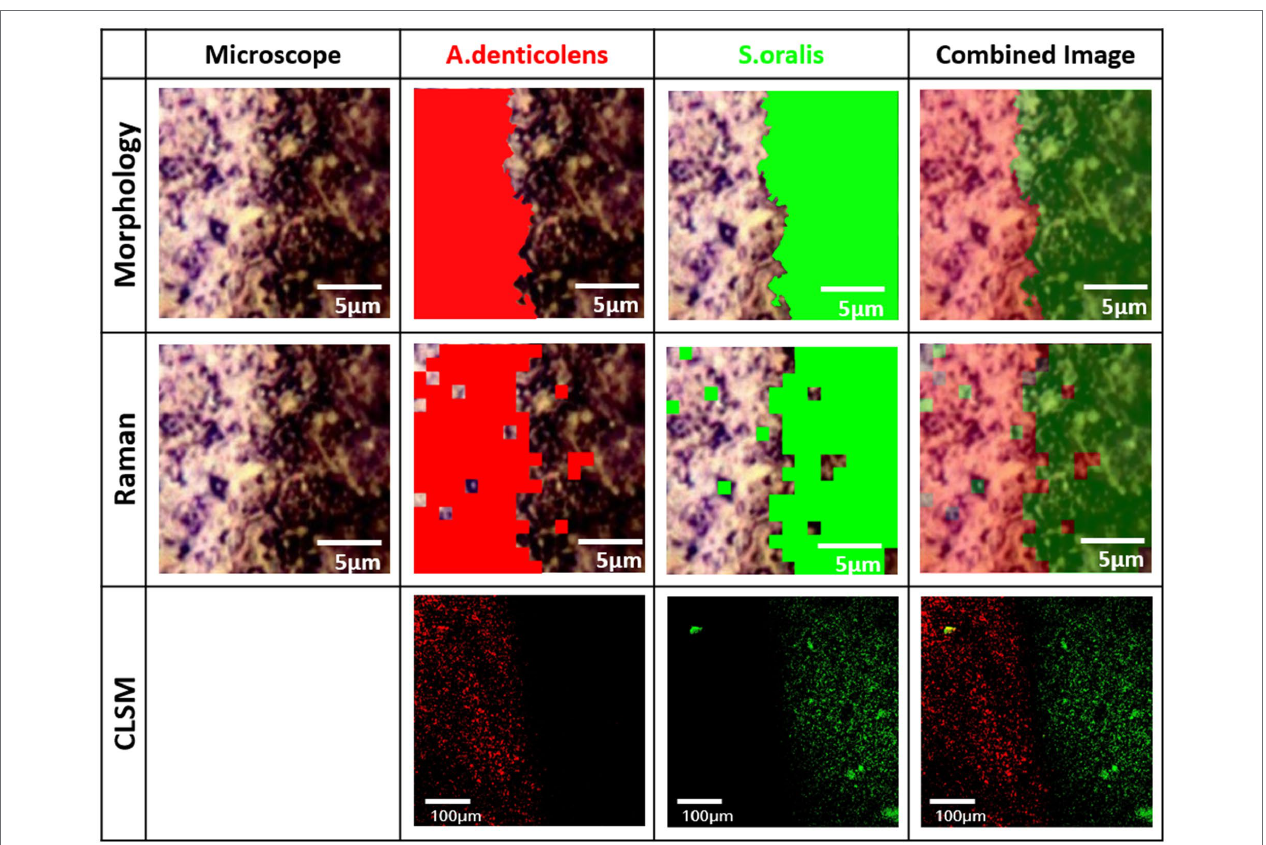
FIGURE 5 | Distribution of A. denticolens and S. oralis in a dense bacteria interface area (DBIA) sample. Morphological and Raman analysis was performed using the identical random area in a sample. Morphological analysis was done using ImageJ with the plugin MorphoLibJ. Raman analysis was performed using PCA- based cluster analysis with WiRE 5.4. FISH analysis was performed on a new sample from the same experimental